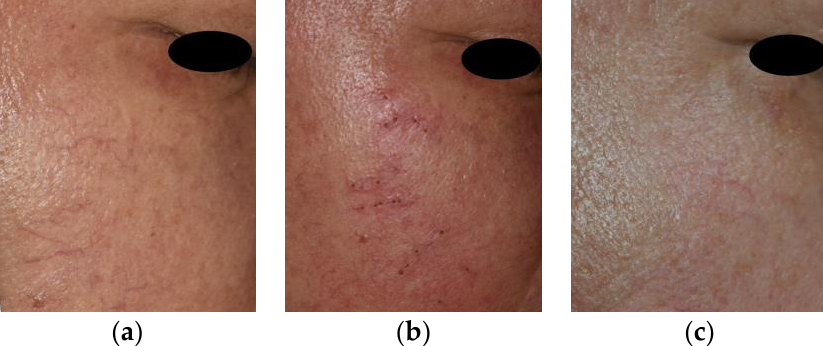
Figure 2. Facial telangiectasia in a 57-year-old man. ( a ) Telangiectasia on the right cheek before treatment. ( b ) Multiple deep holes were made in line with the course of the telangiectasia. ( c ) The telangiectasia showed significant improvement 3-month follow-up.